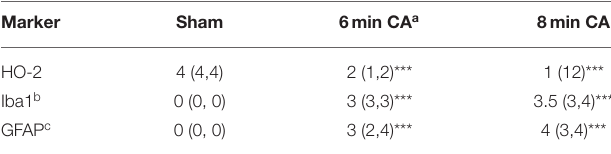
TABLE 3 | Semiquantitative evaluation of HO-2 and markers indicative for activation of astrocytes and microglia in hippocampal sections of rats after 2 weeks following cardiac arrest.